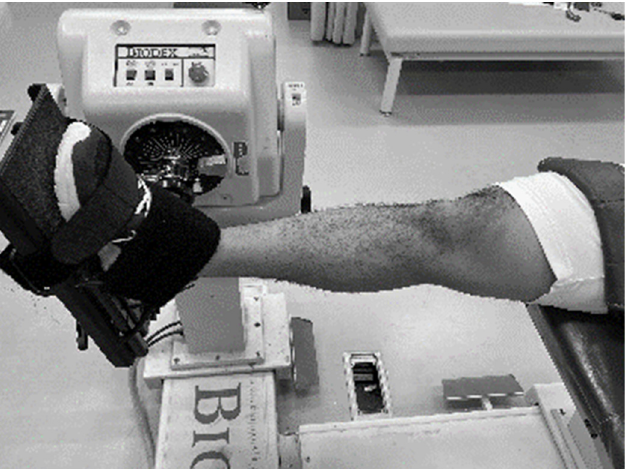
Figure 1. The experimental set-up for range of motion and passive torque measurement.